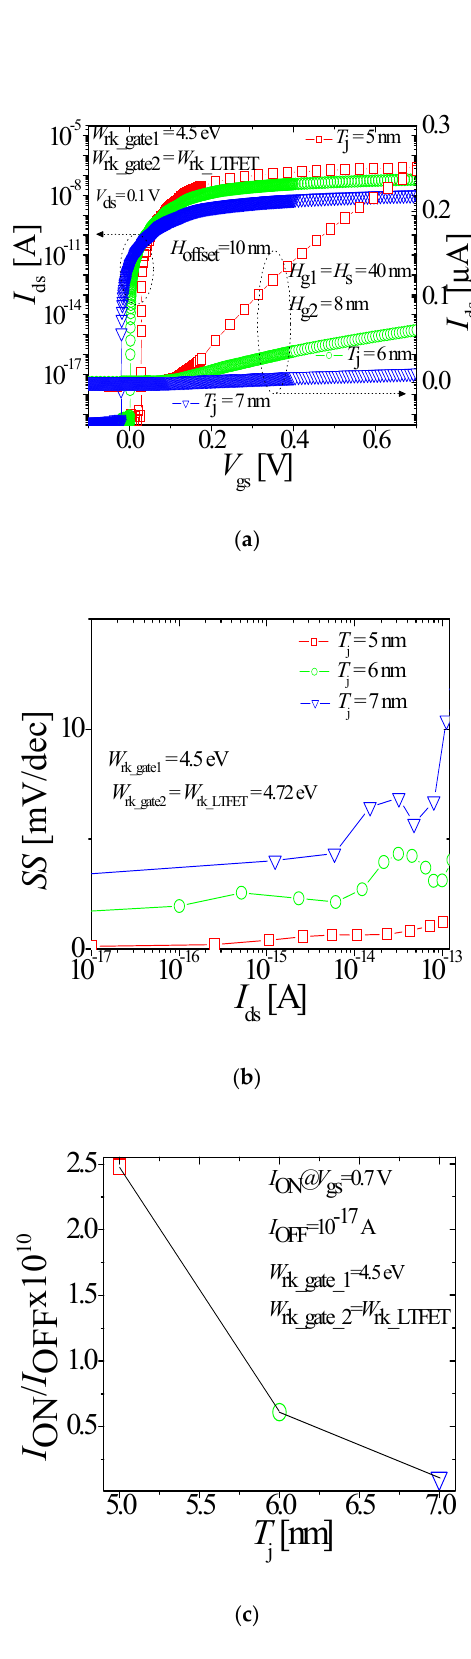
Figure 9. ( a ) I ds - V gs characteristics of the DG-LTFET with different T j and fixed W rk_gate1 = 4.5 eV, W rk_gate2 = W rk_LTFET , and H g1 = H s = H nonoffset = 40 nm, H g2 = H offset (10 nm) − t ox = 8 nm. ( b ) The SS of I ds - V gs shown in Figure 8a. ( c ) I ON / I OFF ratio of I ds - V gs characteristics shown in Figure 8a. Red squares, green circles, and blue triangles: T j = 5, 6 and 7 nm,